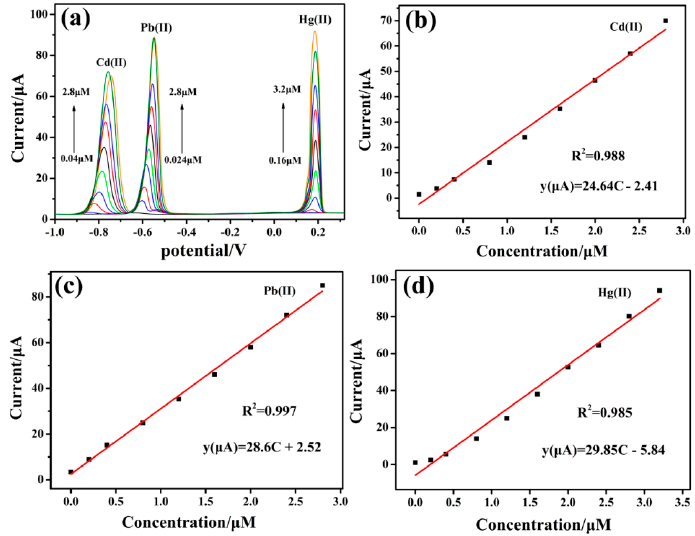
Figure 9. ( a ) DPV response for simultaneous analysis of the Cd(II), Pb(II), and Hg(II) at the PProDOT(MeSH) 2 @Si/GCE; ( b,c,d ) corresponding calibration curves of Cd (II) Pb(II) and